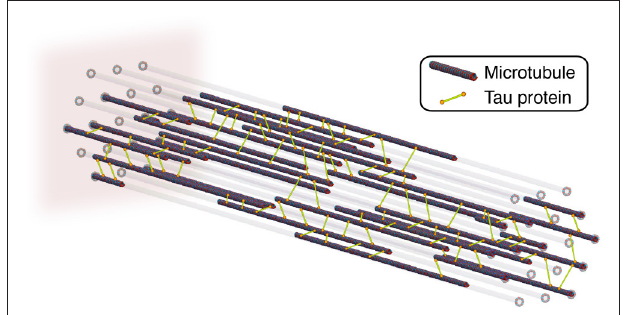
FIGURE 2 | Axon model with longitudinally aligned microtubules that are connected by tau protein crosslinks. To account for axonal dynamics, we model each crosslink as a noncovalent slip bond and assign each crosslink a mechanism of Bell model type. We fix the axon at its distal, left end and apply a stretch, λ , and stretch rate, ˙ λ , to its proximal, right